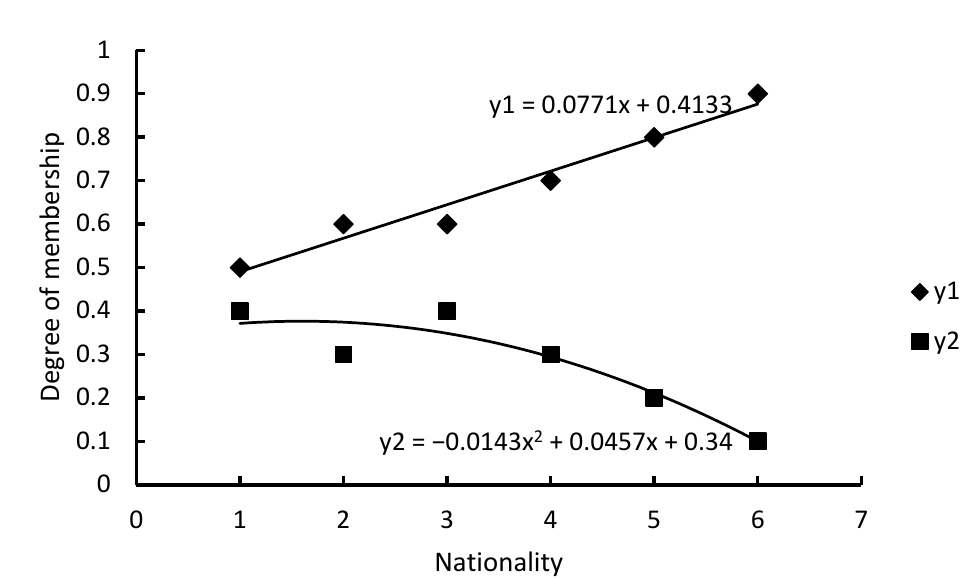
Figure A2. Single factor evaluation for the index of place of residence.